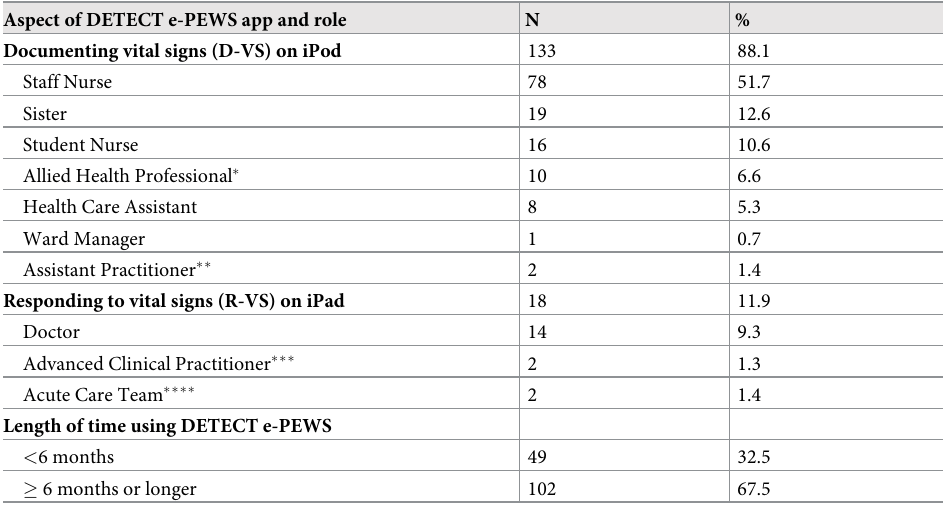
Table 2. Aspect of DETECT e-PEWS app used and professional role. Aspect of DETECT e-PEWS app and